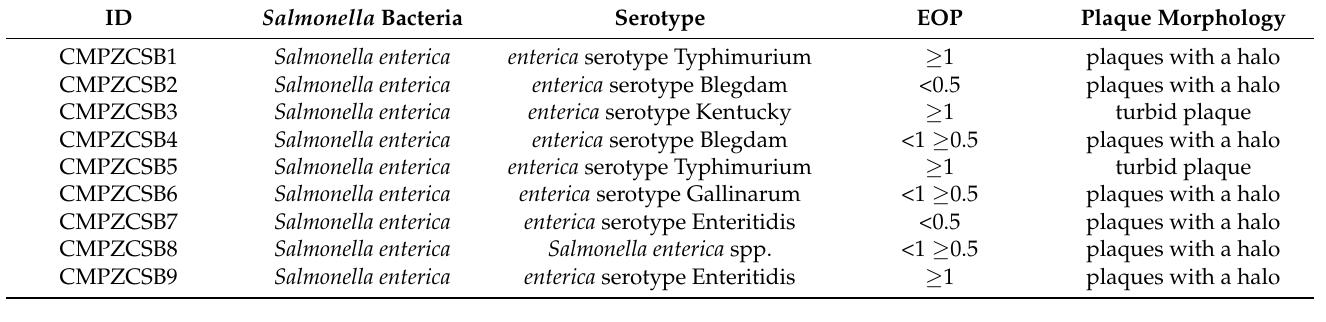
Table 1. Shows the plaque morphology and EOP of ZCSE6 against various Salmonella isolates.